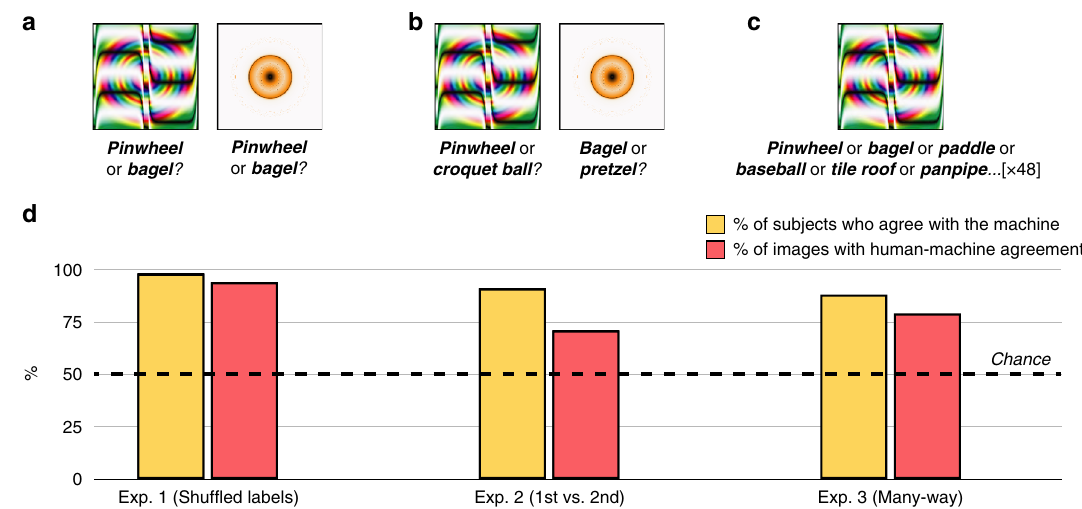
Fig. 2 Forced-choice classi fi cation with indirectly encoded fooling images. a In Experiment 1, 200 subjects saw one fooling image at a time (48 images total), and chose between two candidate labels: The machine ’ s choice for that image, and a random label drawn from the other images in the imageset. b In Experiment 2, 200 subjects chose between the machine ’ s fi rst-choice classi fi cation and its second-choice classi fi cation. c In Experiment 3a, 200 subjects saw the same images as before, but with all 48 labels visible at once. d In all 3 experiments, most subjects agreed with the machine more often than would be predicted by chance responding (yellow bars), and most images showed human-machine agreement more often than would be predicted by chance responding (red bars). Given that raw classi fi cation accuracy in human subjects will be modulated by factors such as attention, motivation, engagement with the task, time spent studying an image, etc., we report the percentage of subjects who agreed with the machine at above-chance rates, and the percentage of images that showed above-chance human-machine agreement. For Experiment 1, the 95% con fi dence interval for the % of subjects with above-chance classi fi cation was [94.6% 99.4%], and it was [82.8% 98.7%] for the % of images with above-chance classi fi cation. For Experiment 2, these intervals were [87.7% 95.7%] and [58.0% 83.7%], respectively. For Experiment 3, these intervals were [83.2% 93.2%] and [67.7% 90.7%], respectively. Across all three experiments, these outcomes were reliably different from chance at p < 0.001 (two-sided binomial probability